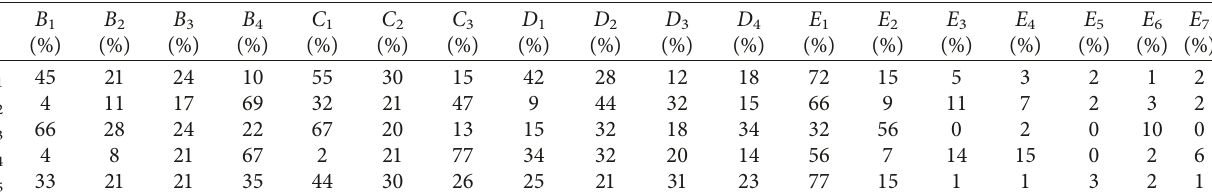
Table 4: Association rules with A � > B , A � > C , A � > D , and A � > E